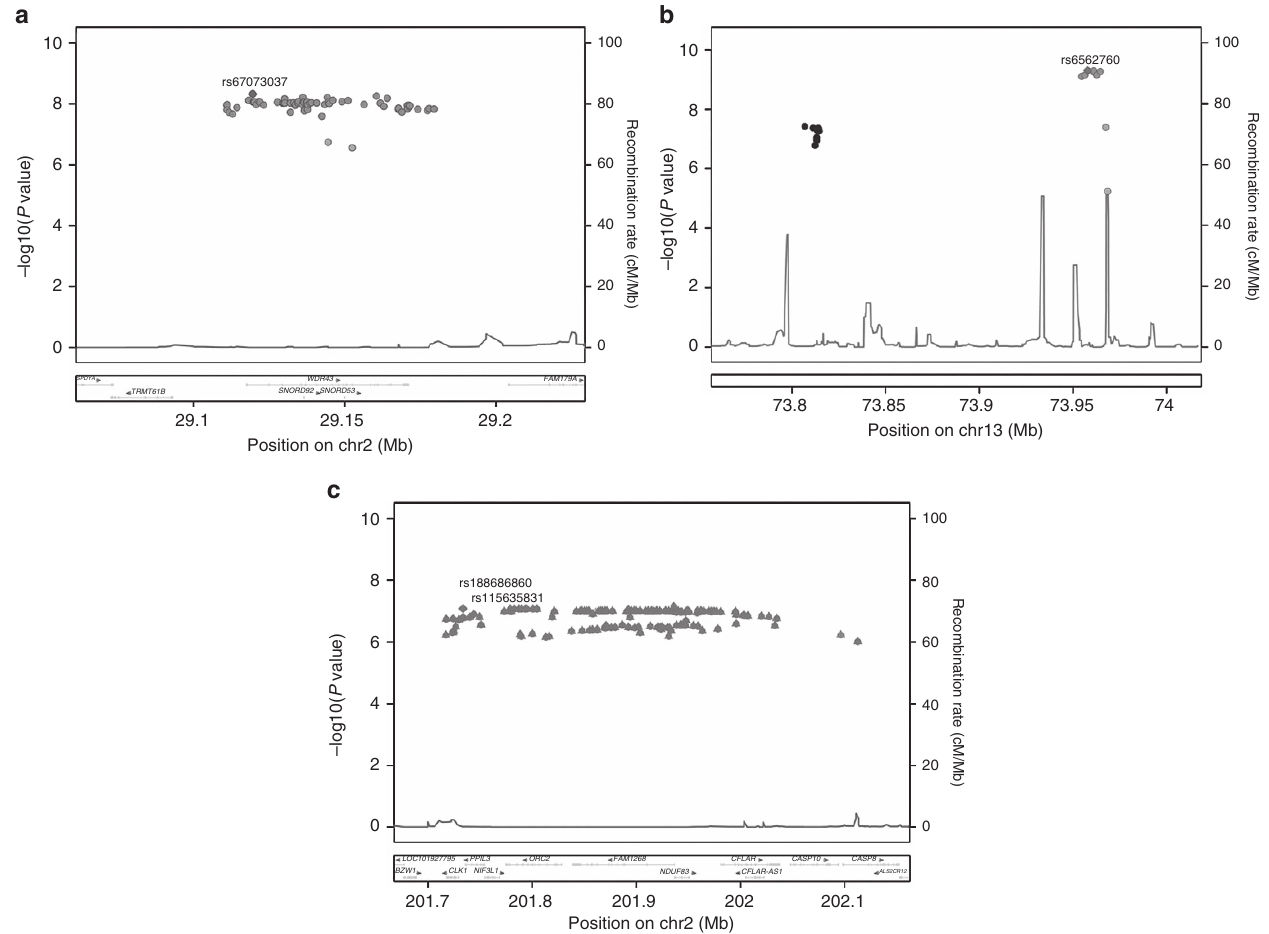
Figure 2 | Novel ER-negative breast cancer loci. The chromosomal position and strength of genetic association ( (cid:3) log 10 P ) is shown for all SNPs ( P o 1 (cid:2) 10 (cid:3) 6 ) in BCAC/iCOGS data in the four novel risk loci. ( a ). 2p23 locus. The most significant SNP (rs67073037) is shown as a diamond. ( b ). 13q22 loci. The most significant SNP (rs6562760) is shown as a diamond. The second locus is shown in black. ( c ). 2q33 locus. The most significant SNPs (rs188686860; rs115635831) are shown as significantly associated ( P 4 0.05) with breast cancer risk for BRCA1 mutation carriers. No significant interactions between the known risk SNPs were observed when pairwise interactions were evaluated separately in the general population (BCAC-iCOGS) or in BRCA1 carriers after adjusting for multiple testing.